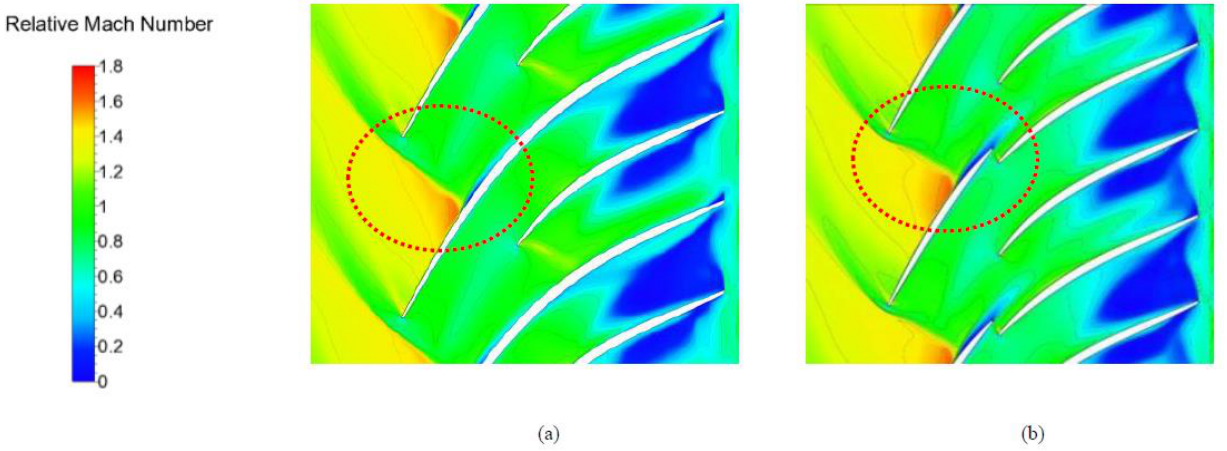
Figure 12. Comparison of the relative Mach number distribution at a 95% span ( P.E. point). ( a ) Conventional impeller, and ( b ) baseline tandem impeller.